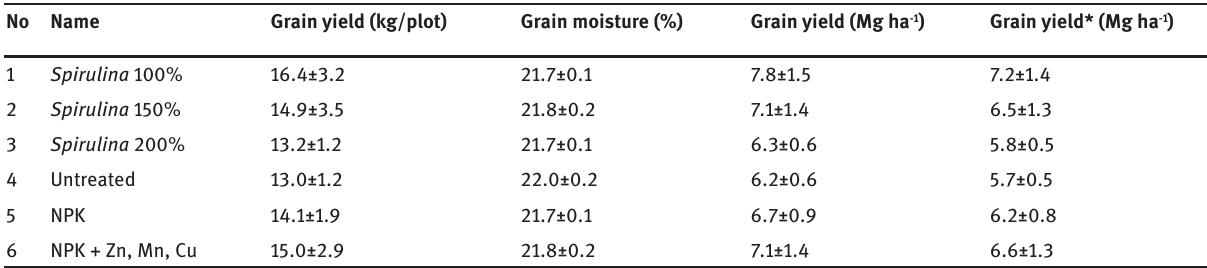
Table 4: Crop properties.